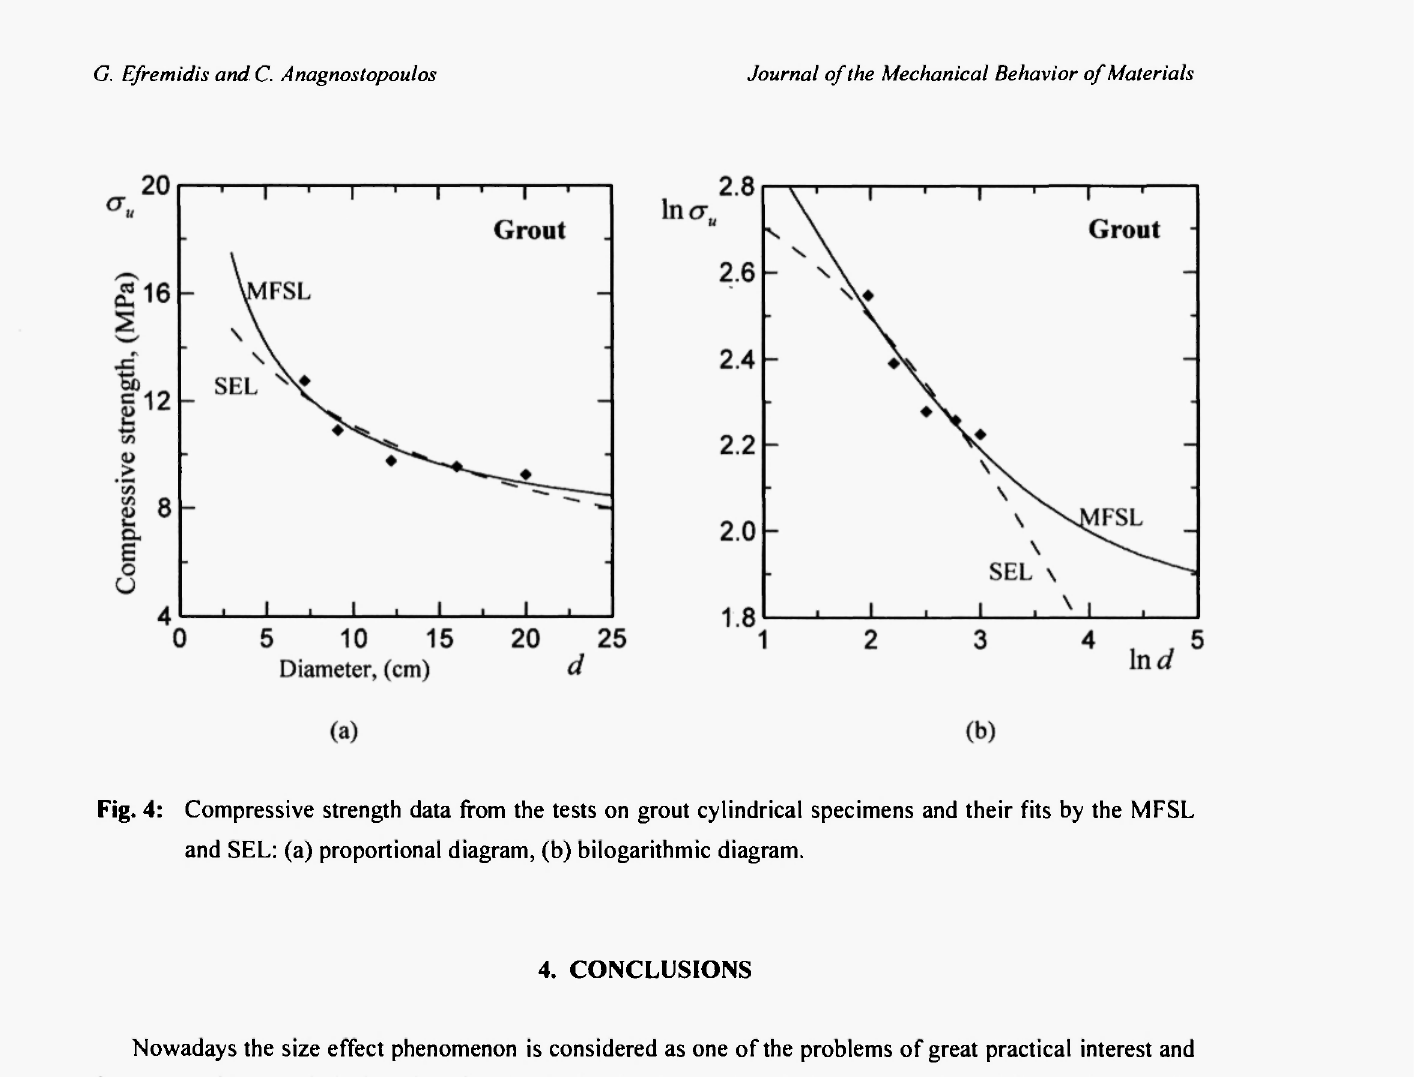
Fig. 4: Compressive strength data from the tests on grout cylindrical specimens and their fits by the MFSL and SEL: (a) proportional diagram, (b) bilogarithmic